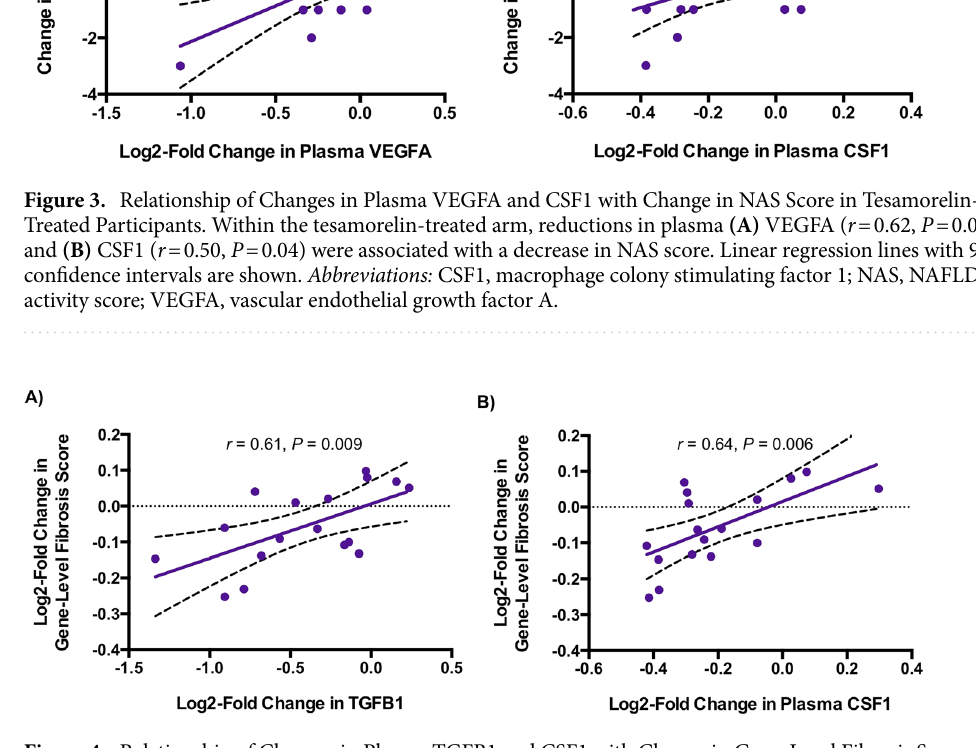
Figure 4. Relationship of Changes in Plasma TGFB1 and CSF1 with Change in Gene-Level Fibrosis Score in Tesamorelin-Treated Participants. Among tesamorelin-treated participants, declines in plasma ( A) TGFB1 (r = 0.61, P = 0.009) and (B) CSF1 ( r = 0.64, P = 0.006) were associated with improved gene-level fibrosis score. Linear regression lines with 95% confidence intervals are shown. Abbreviations: CSF1, macrophage colony stimulating factor 1; TGFB1, transforming growth factor beta